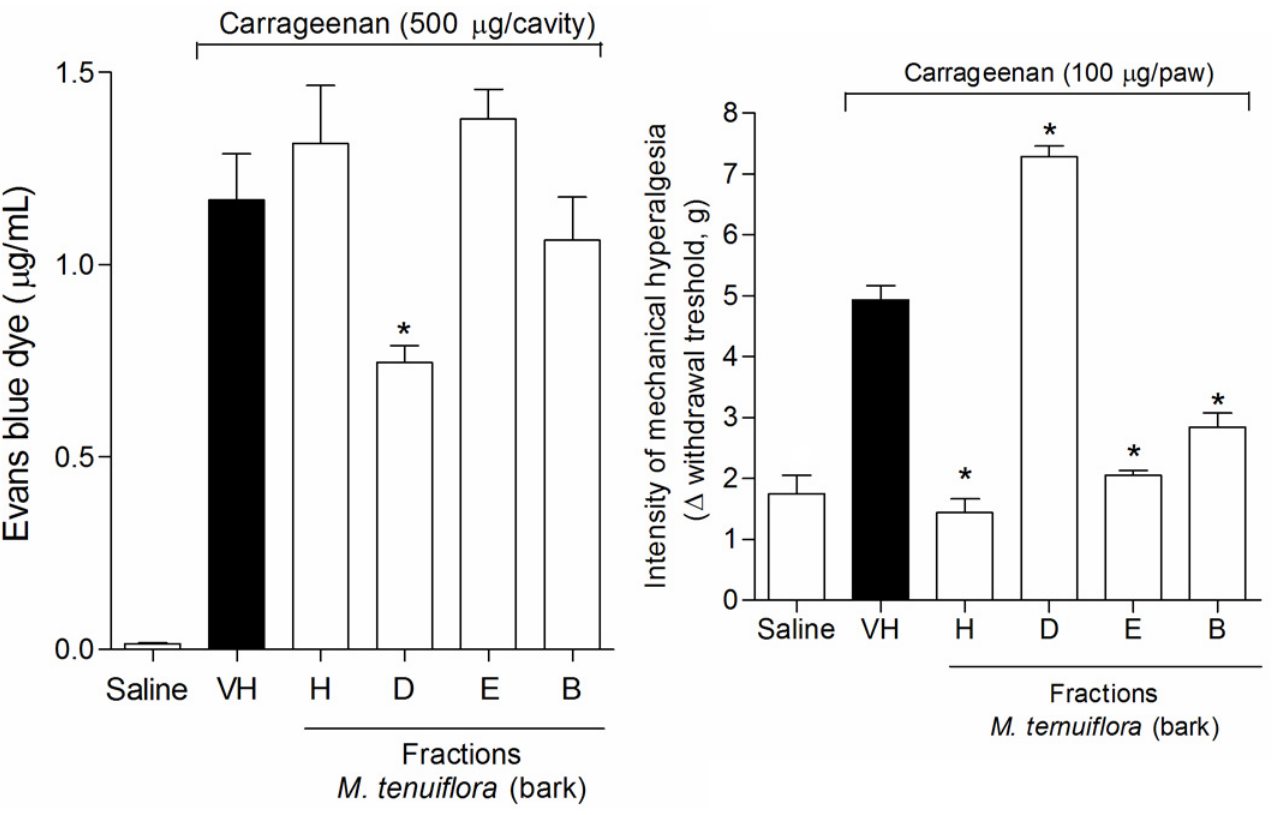
Fig 15. Effect of the hexane (H), DCM (D), EtOAc (E) and BuOH (B) (100 mg/kg) soluble fractions of M . tenuiflora bark in the Evans blue (A) and Von Frey tests (B). VH is the vehicle group (negative control). The results are presented as the mean ± S.D. (n = 8). Statistical significance was calculated by ANOVA followed by Bonferroni's test. * P < 0.05 compared to the vehicle-negative control treated